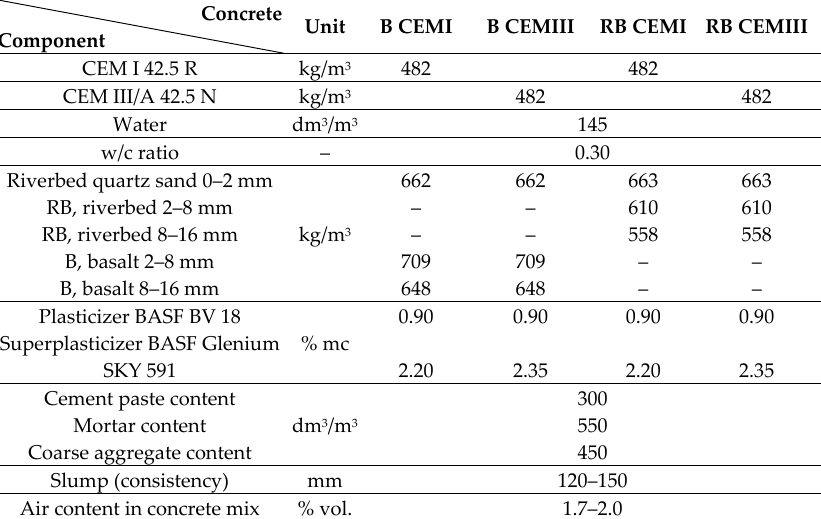
Table 4. Mix composition of the test concretes.